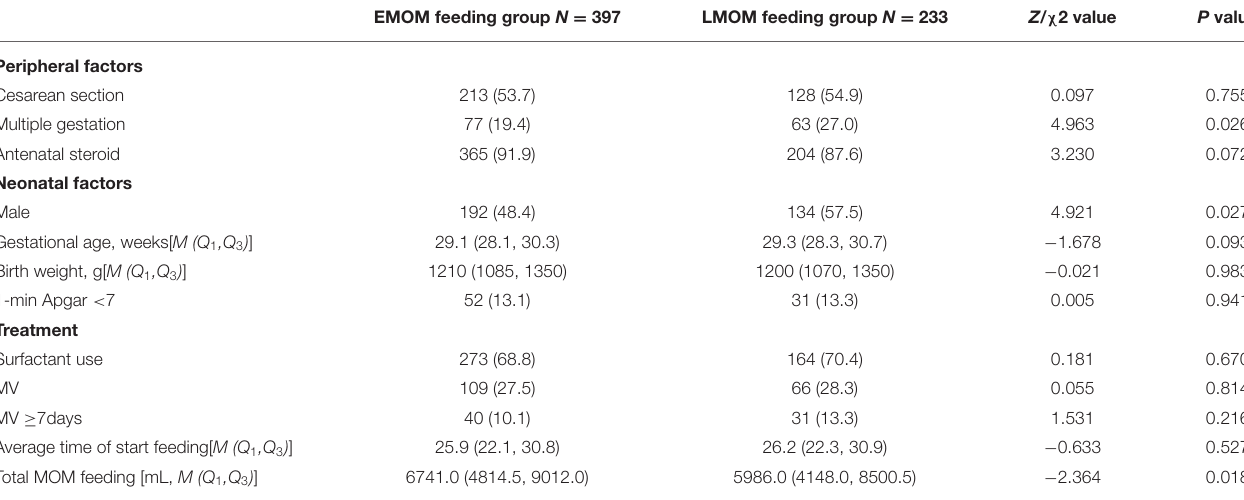
TABLE 1 | Clinical characteristics and treatment (Example [%]).